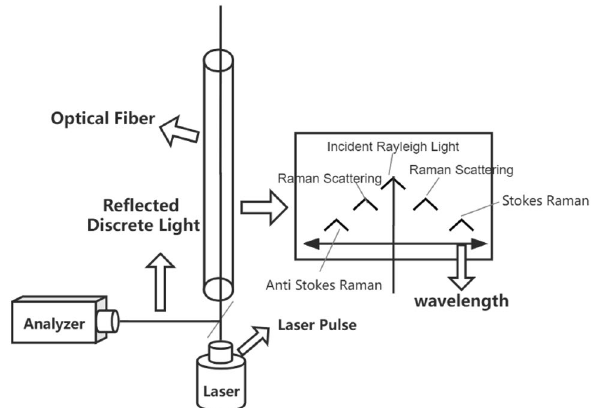
Fig. 2 Schematic diagram of distributed optical fiber vibration sig- nal monitoring